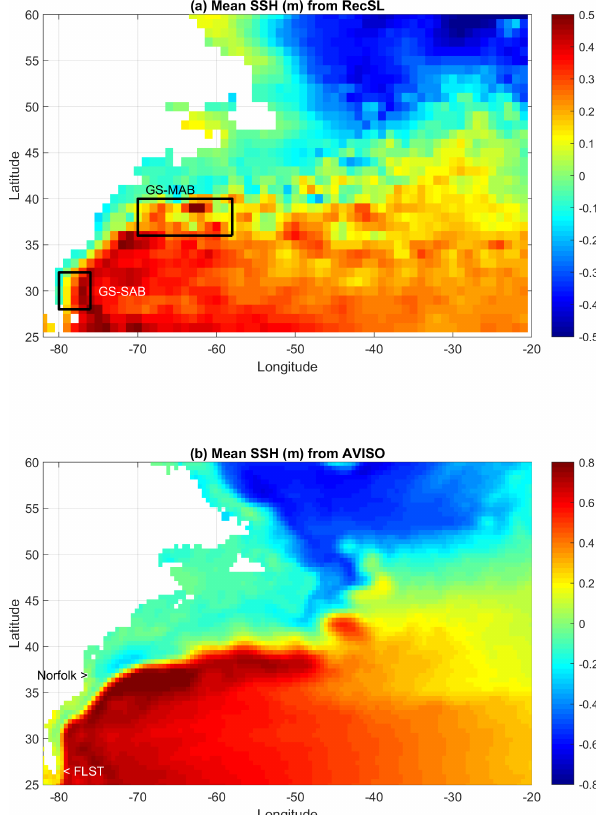
Figure 1. Mean sea surface height in the North Atlantic Ocean dur- ing the satellite era (1993–2015) obtained from (a) the RecSL re- construction on a 1 ◦ × 1 ◦ grid and (b) the AVISO altimeter data on a 1 / 4 ◦ × 1 / 4 ◦ grid. Note the different color scale. The regions where the proxy Gulf Stream is defined in the Mid-Atlantic Bight (MAB) and the South Atlantic Bight (SAB) are marked in (a) , and the location of the observations of the Norfolk sea level and the Florida Current transport at the Florida Straits (FLST) are marked in (b)